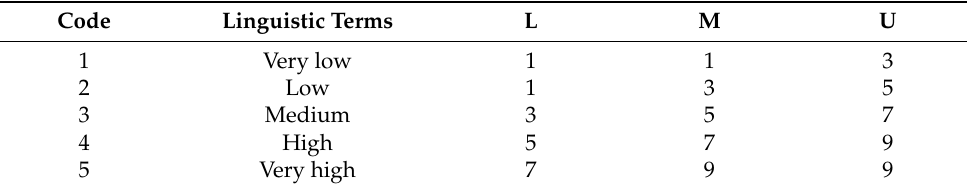
Figure 3. Flow diagram of Fuzzy TOPSIS approach. Table 3. Fuzzy-logic-based